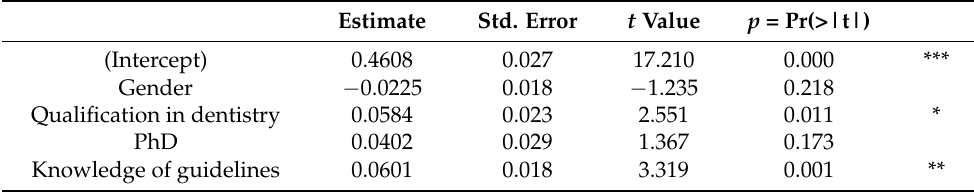
Table 4. Model estimation for average